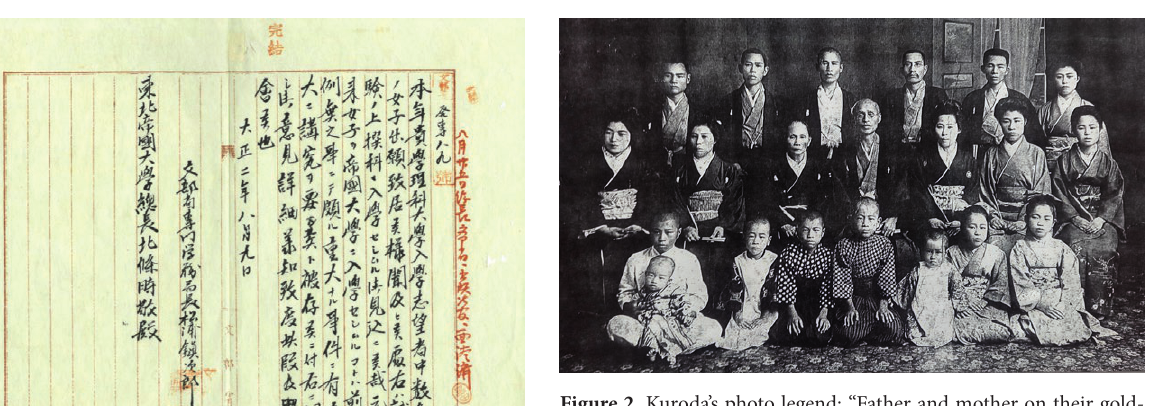
Figure 2. Kuroda’s photo legend: “Father and mother on their gold- en wedding anniversary and I (2 nd row second from right) Tohoku Imperial University graduation commemoration.” (Courtesy of Tohoku University and Kuroda